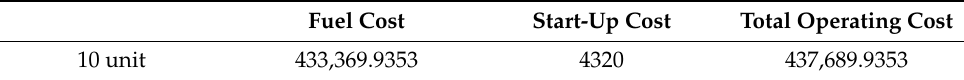
Figure 6. Performance of 10-generating units over 24 h (test system 2). Table 13. Fuel cost, start-up cost and total operating cost obtained by MPSO-EO (test system 2).